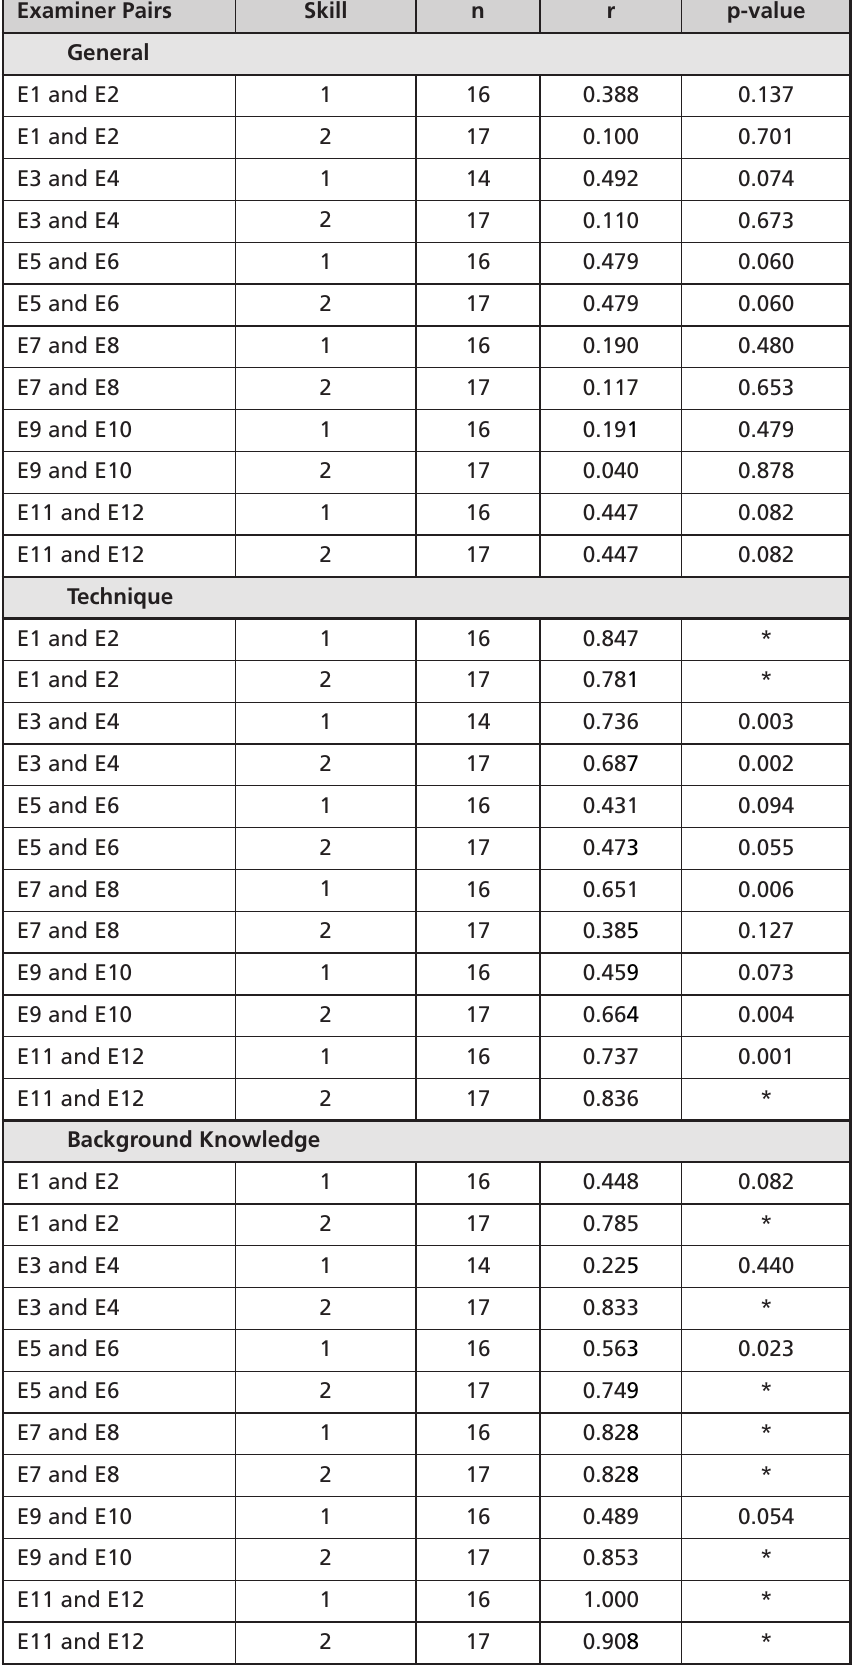
Table 5: Correlations for marks allocated per sub-section (general, technique, background) of the same